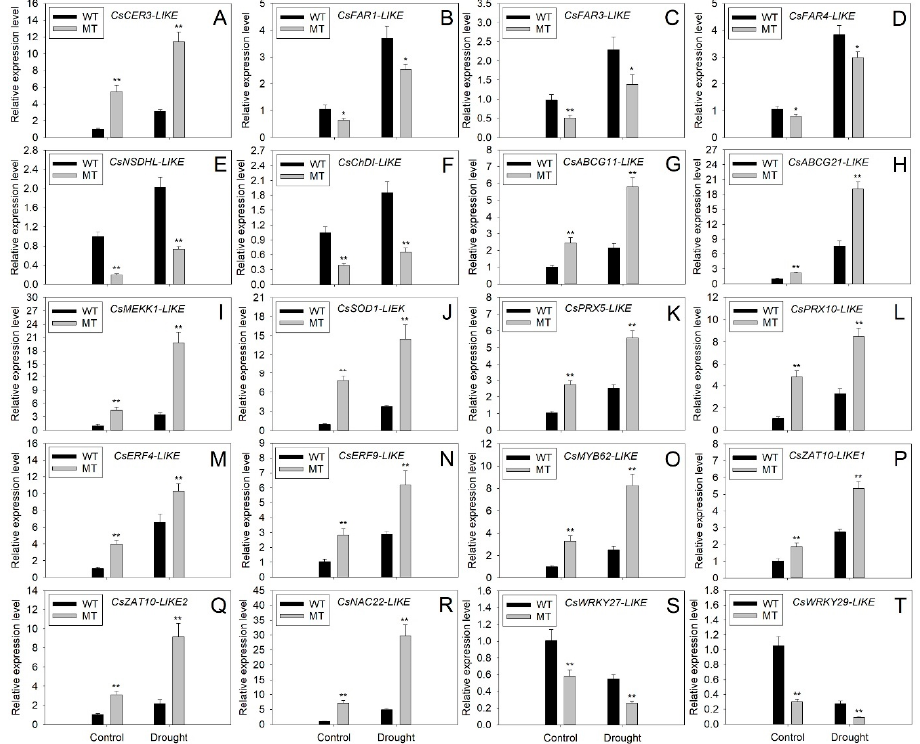
Figure 10. Expression analysis of structural differentially expressed genes (DEGs) involved in ( A – F ) wax biosynthesis and ( G , H ) export, ( I ) MAPK cascade, ( J – L ) ROS scavenging and ( M – T ) DEGs encoding transcription factors under control (well − watered) and drought conditions (without wa- tering for 21 days). The y − axis records the relative gene expression levels calculated by the 2 −ΔΔ CT method with citrus β − actin as the endogenous reference. Vertical bars represent standard deviations of the means ( n = 3). Significant differences between WT and MT leaves at the p < 0.05 and p < 0.01 levels were indicated by * and **, respectively, according to Student’s t − test.